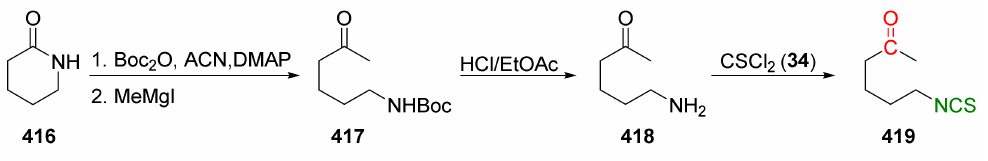
Figure 45. Synthesis of 2-oxohexyl isothiocyanate ( 419 ).